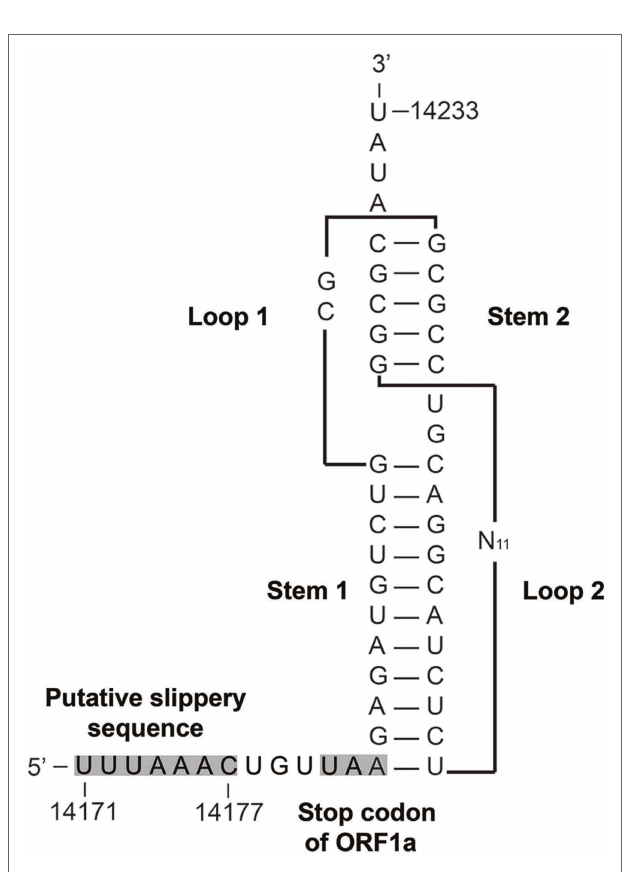
FIGURE 3 | Predicted structure of the AToV ribosomal frameshifting element. The putative slippery sequence and the ORF1a translation termination codon are shaded in gray. N 11 indicated 11 unshown nucleotides.